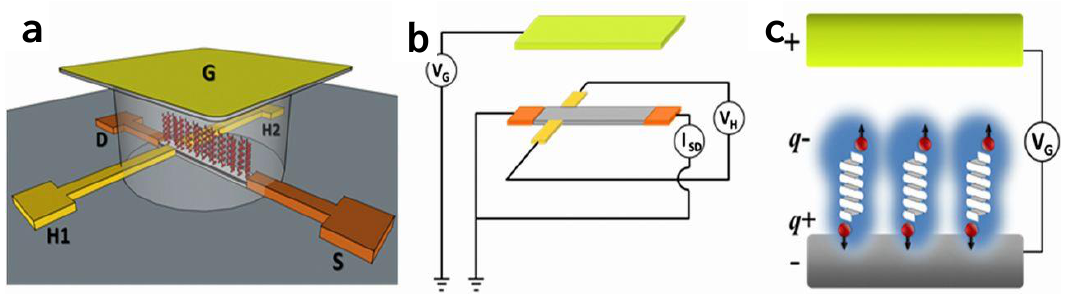
Figure 8. ( a ) Pictorial view of experimental setup, ( b ) electrical connections, and ( c ) concept behind